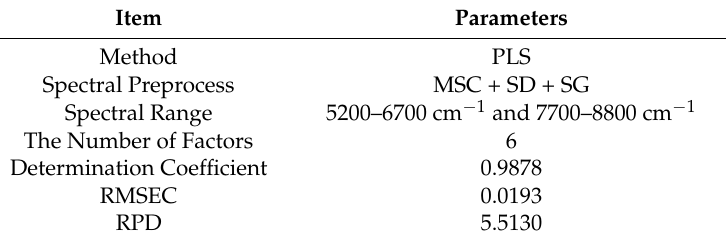
Table 5. The parameters of the